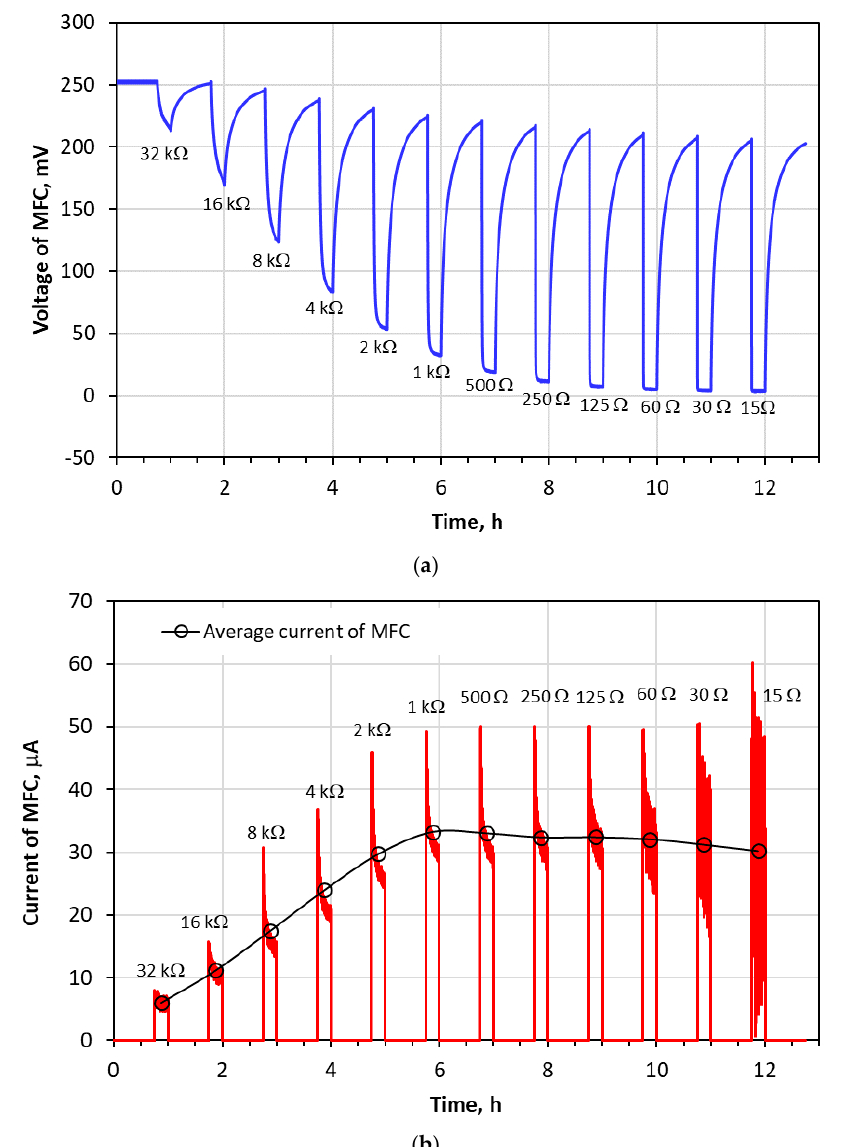
Figure 4. Dependence of voltage ( a ) and current ( b ) of microbial fuel cell (MFC) on different applied electric load.